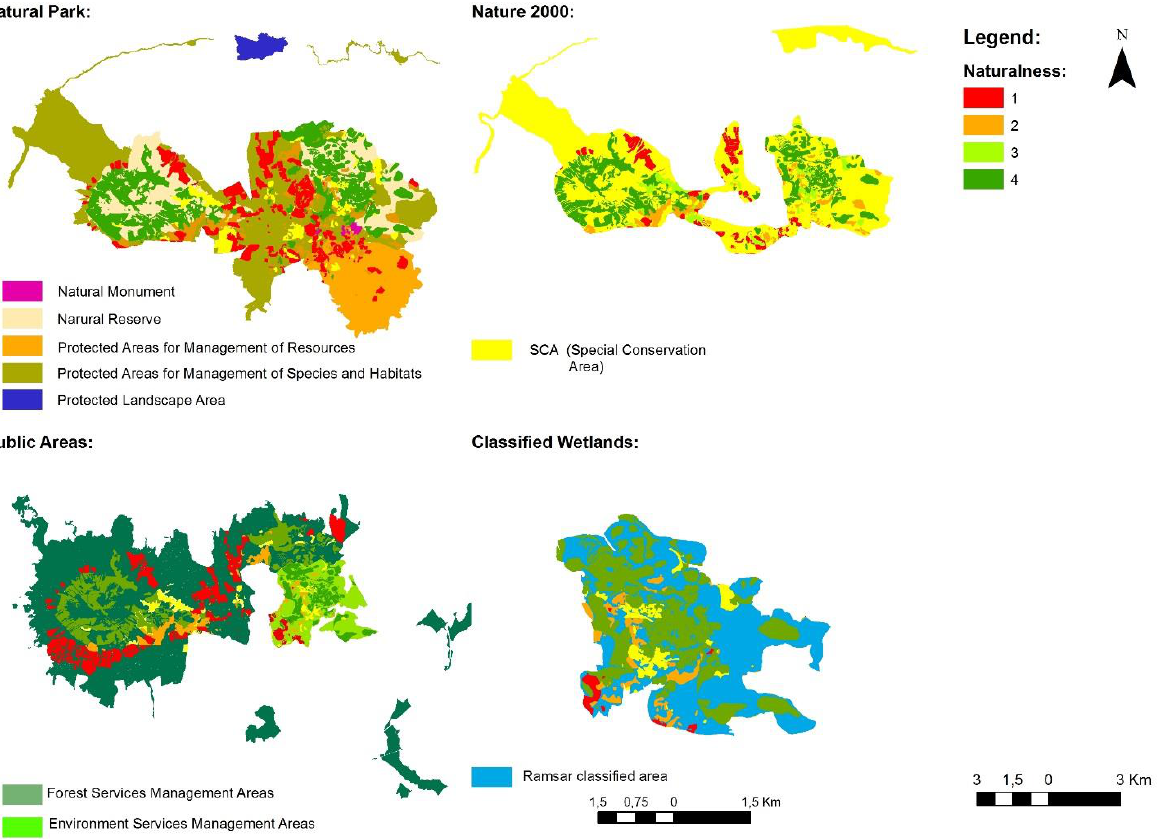
Figure 5. Intersection of peatland classes (1 = disturbed; 2 = altered; 3 = conserved; 4 = wild) with protected areas designated for the preservation of natural entities: Natural Park, Natura 2000 SCA, Ramsar Wetlands of International Importance and public areas under Forestry Services and Environmental Services responsibility. Digital base map: Military Map 1:25000. Projection System: U.T.M. Local Data: Graciosa base SW 1948 Zone 26S. Font: